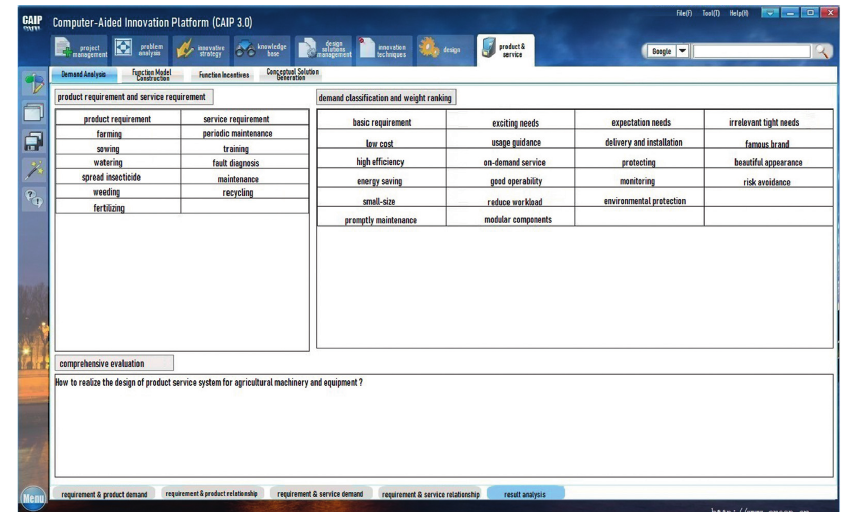
Figure 4: Analysis submodule of customers’ demand of agricultural machinery based on CAIP 3.0.